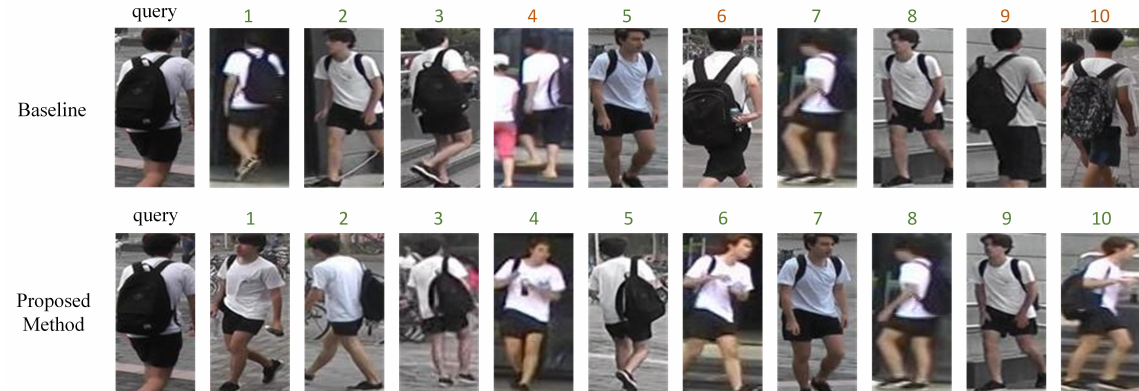
Figure 5. Comparison of retrieval results on the Market-1501 dataset.